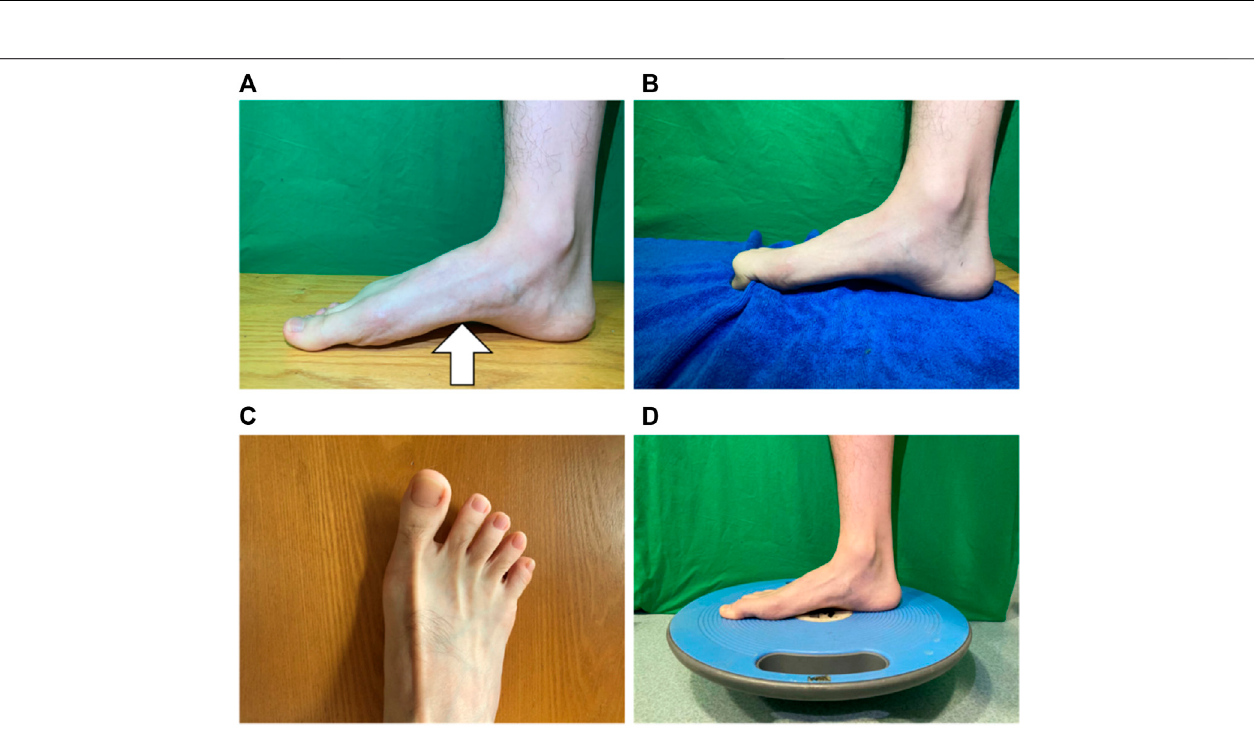
FIGURE 2 | Foot core exercise. (A) short foot exercise; (B) towel curls; (C) toe spread and squeeze; and (D) balance board